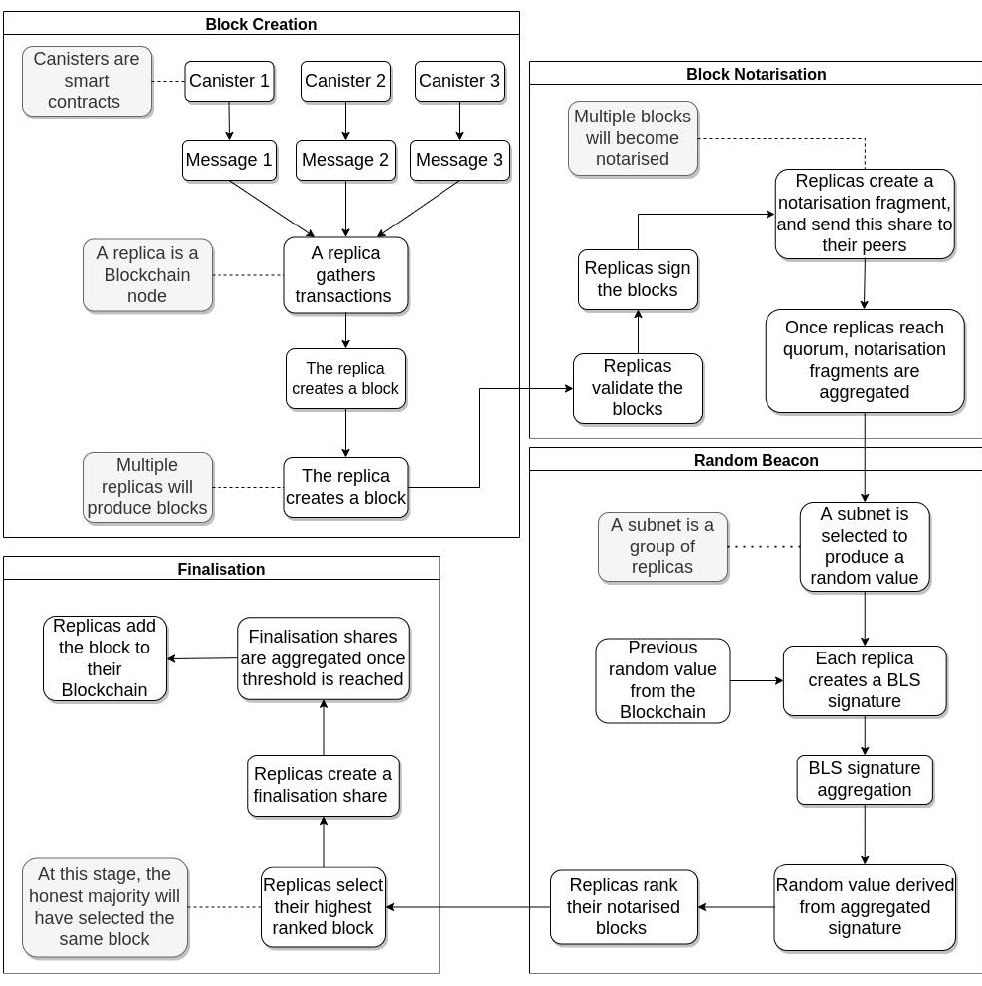
Figure 6. Dinifity